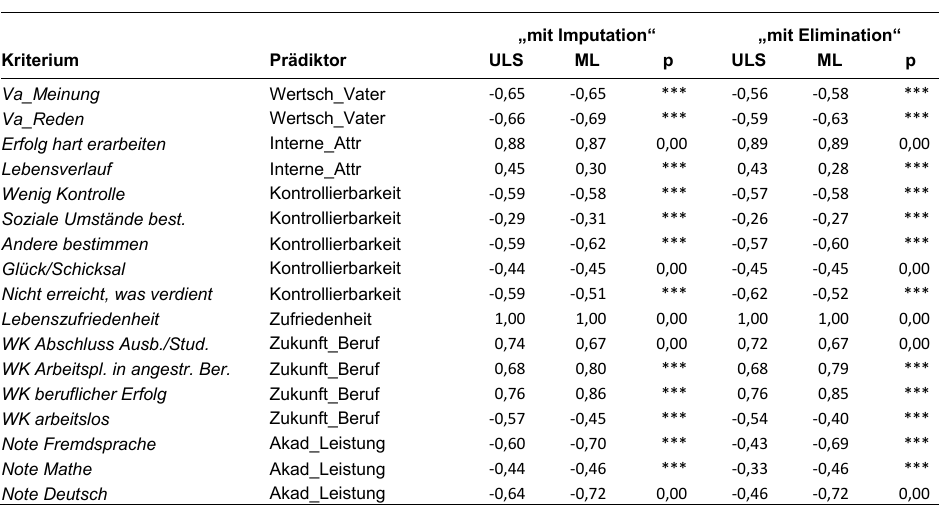
Tabelle 5 : Nichtstandardisierte ULS-Schätzer nach